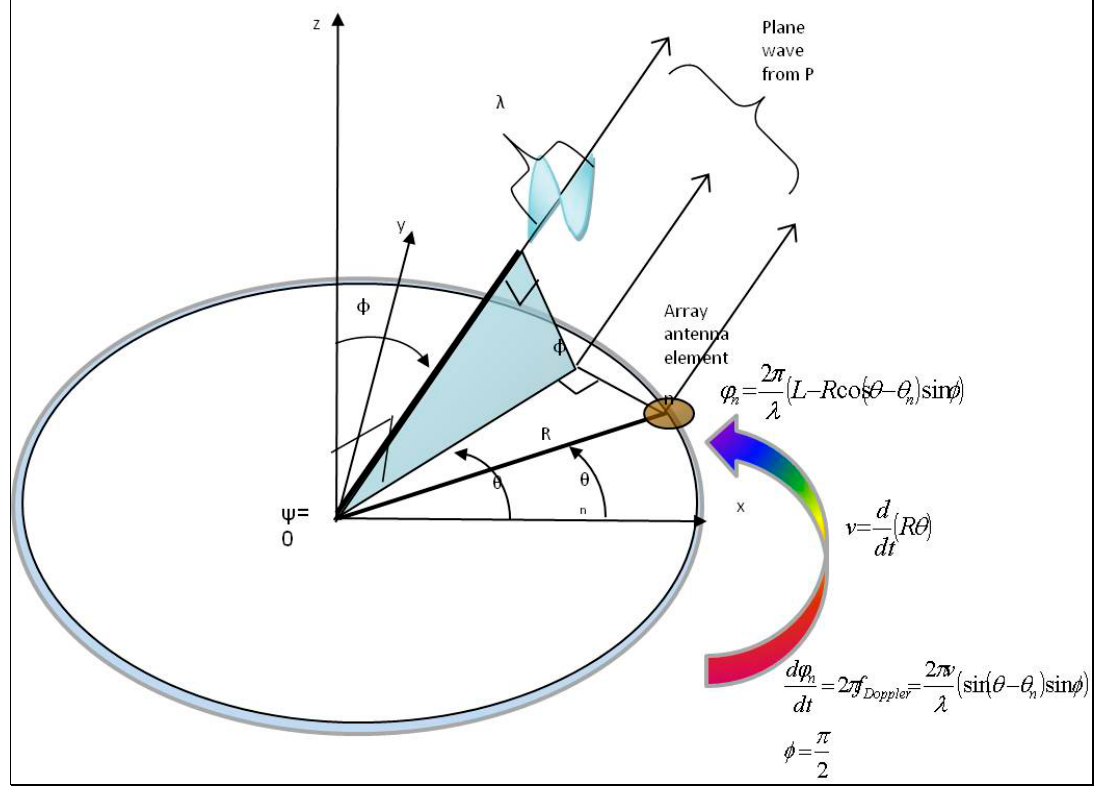
Figure 1. Geometry for Doppler-based direction-finding.